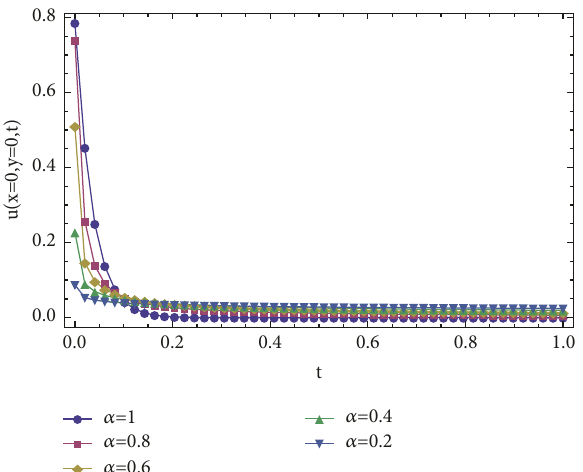
Figure 3: Plot of 𝑢(𝑥 = 0,𝑦 = 0,𝑡) for various values of 𝛼 .